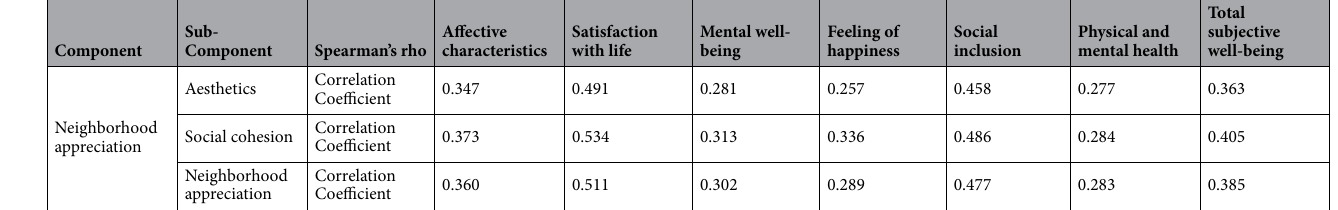
Table 6. The correlation of neighborhood appreciation and its sub-components with the constituent components of citizens’ subjective